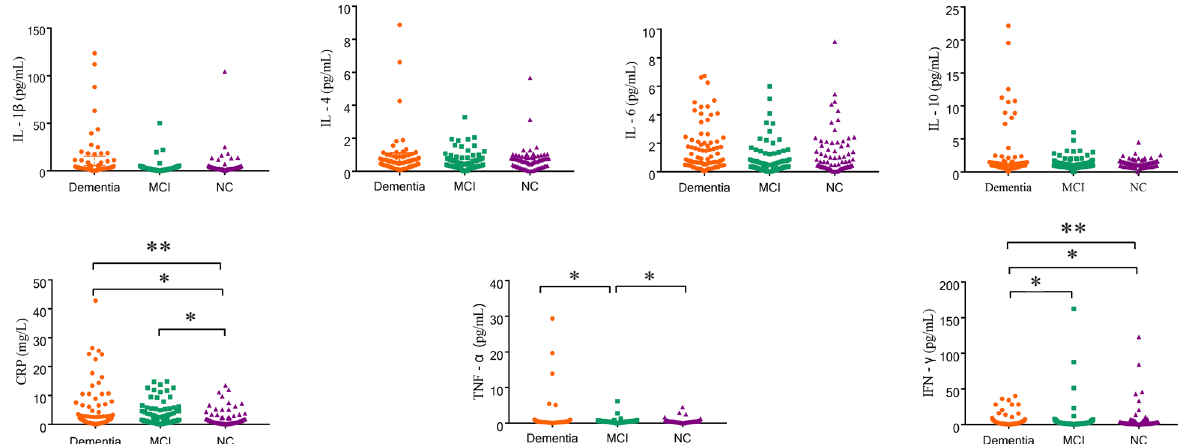
Fig. 1 The scatter plots of different levels of in fl ammatory factors among dementia, MCI, and NC groups. The scatter plots show the different levels of anti-in fl ammatory and proin fl ammatory factors in dementia (orange), MCI (green), and NC (purple) groups. Anti- in fl ammatory factors include IL-4 and IL-10, while proin fl ammatory factors include IL-1 β , IL-6, CRP, IFN- γ , and TNF- α . *There were signi fi cant differences between the two groups ( p < 0.017); **There are signi fi cant differences for the trend tests ( p < 0.05). NC normal cognitive